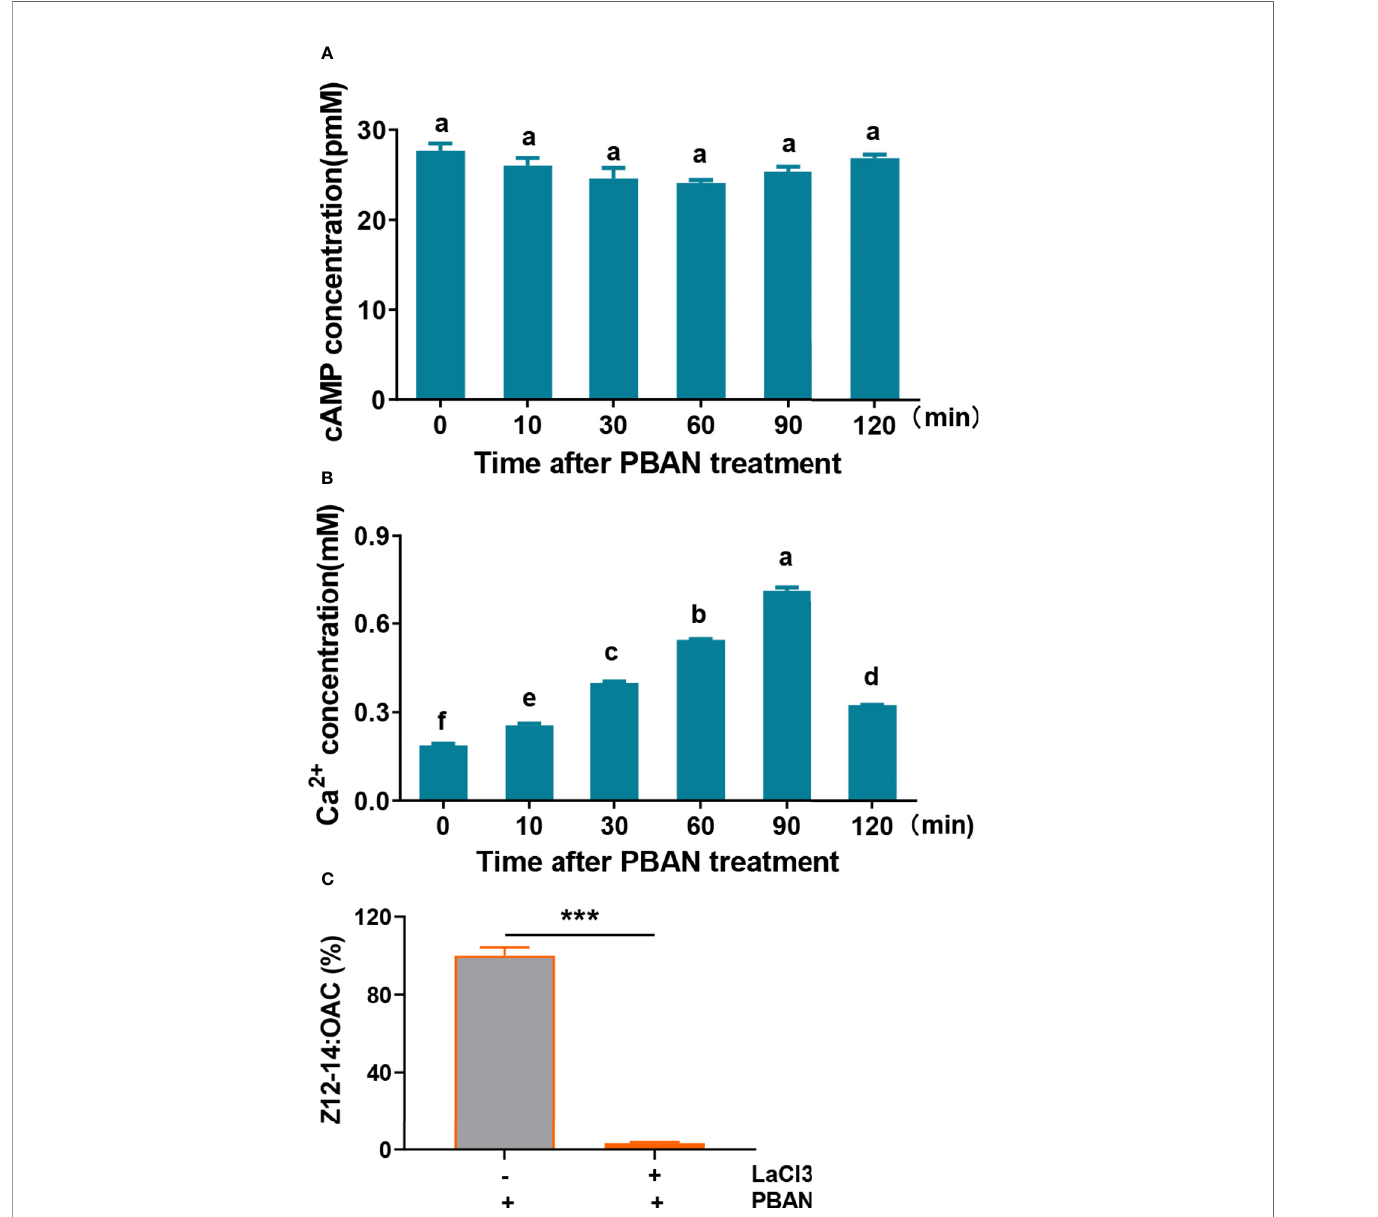
FIGURE 2 | Second messengers of PBAN signal in O. furnacalis . (A) cAMP level in PGs after PBAN challenge in O. furnacalis . (B) The concentration of Ca 2+ in PGs after PBAN incubation in O. furnacalis . Data represent the mean ± SE (n = 3). A multiple comparison test with P < 0.05 was conducted to test the signi fi cant differences in different development time points (based on Tukey ’ s test, DPS7.05). (C) Effect of the calcium channel inhibitor LaCl 3 on sex pheromone production in O. furnacalis PGs. Data represent the mean ± SE (n = 3). Statistically signi fi cant difference was denoted with *** ( P < 0.001) as determined by Student ’ s t -test. Small letters a-f indicate signi fi cant